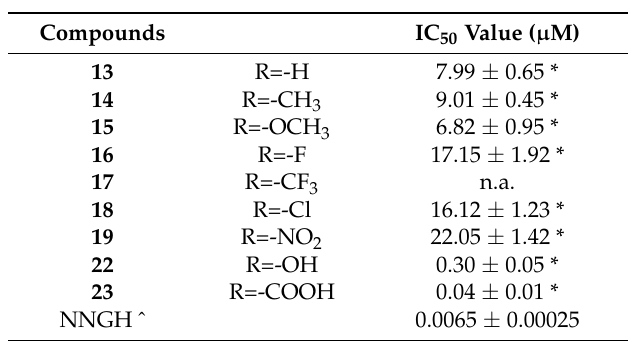
Table 2. In vitro inhibitory activity of 4-thiazolidinones 13 – 19 , 22 and 23 toward